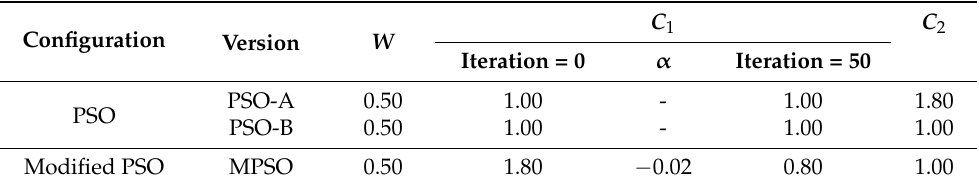
Table 2. Configuration of acceleration parameters in particle swarm optimization (PSO) and modified PSO (MPSO) for 50